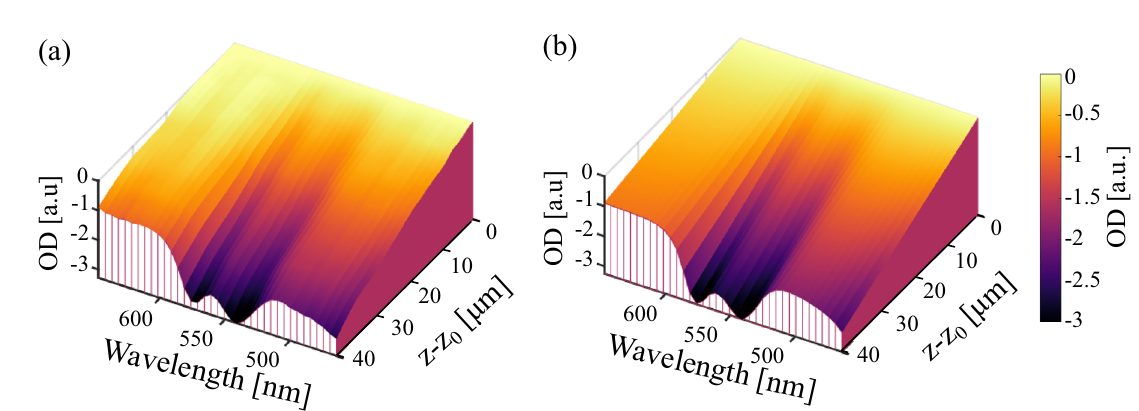
OD after the algorithm (cid:31)